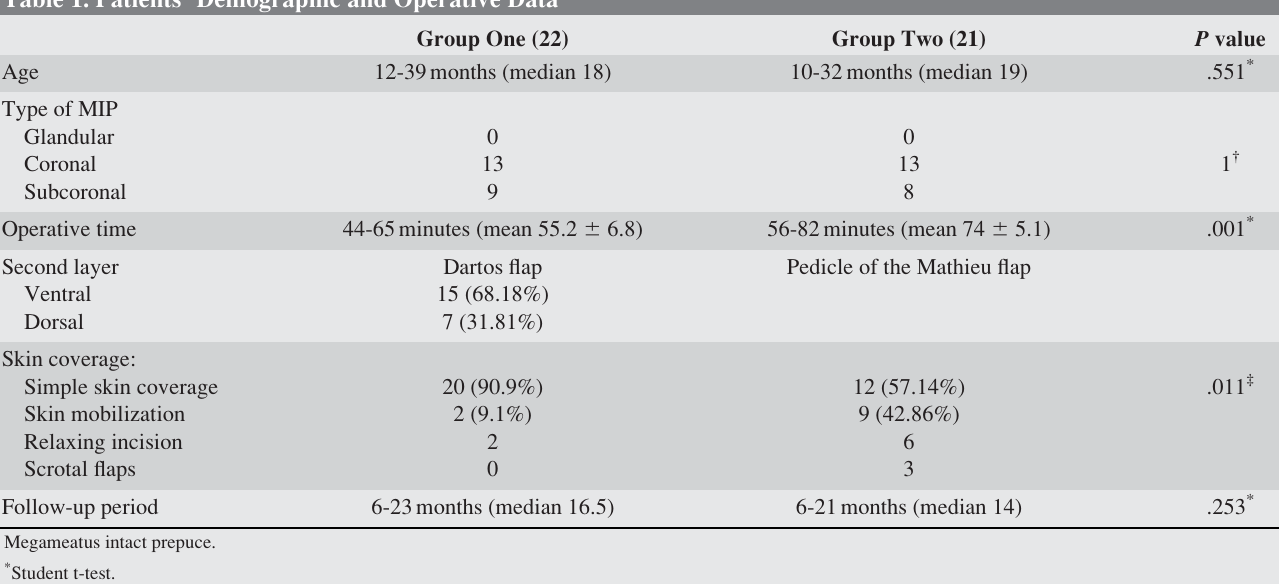
Table 1. Patients’ Demographic and Operative